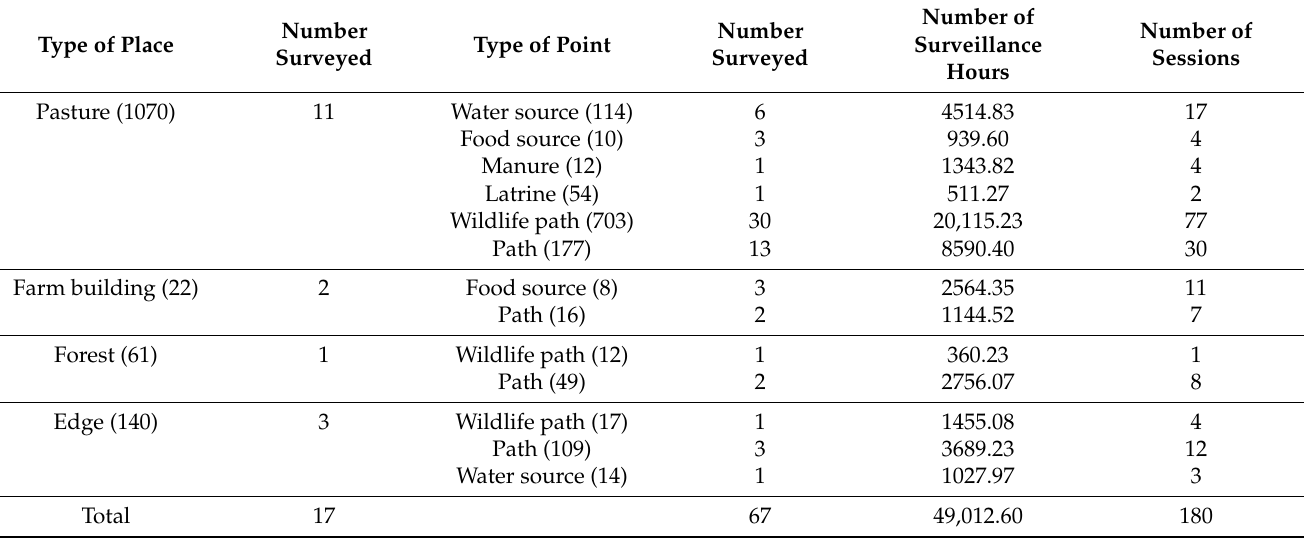
Table 1. Number of visits, surveillance recording hours and sessions grouped by type of place and point.